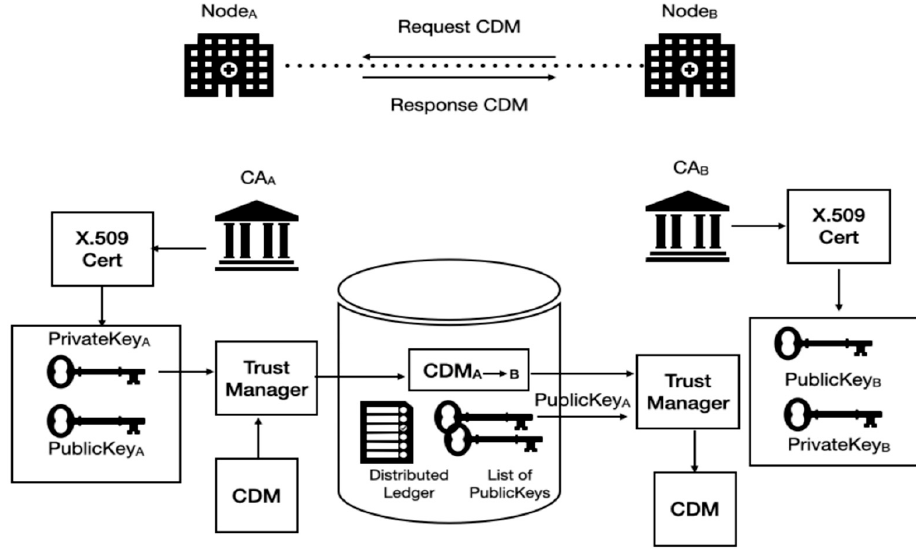
Figure 3. Concept of the Secure-Cloud Common Data Model (SC-CDM).